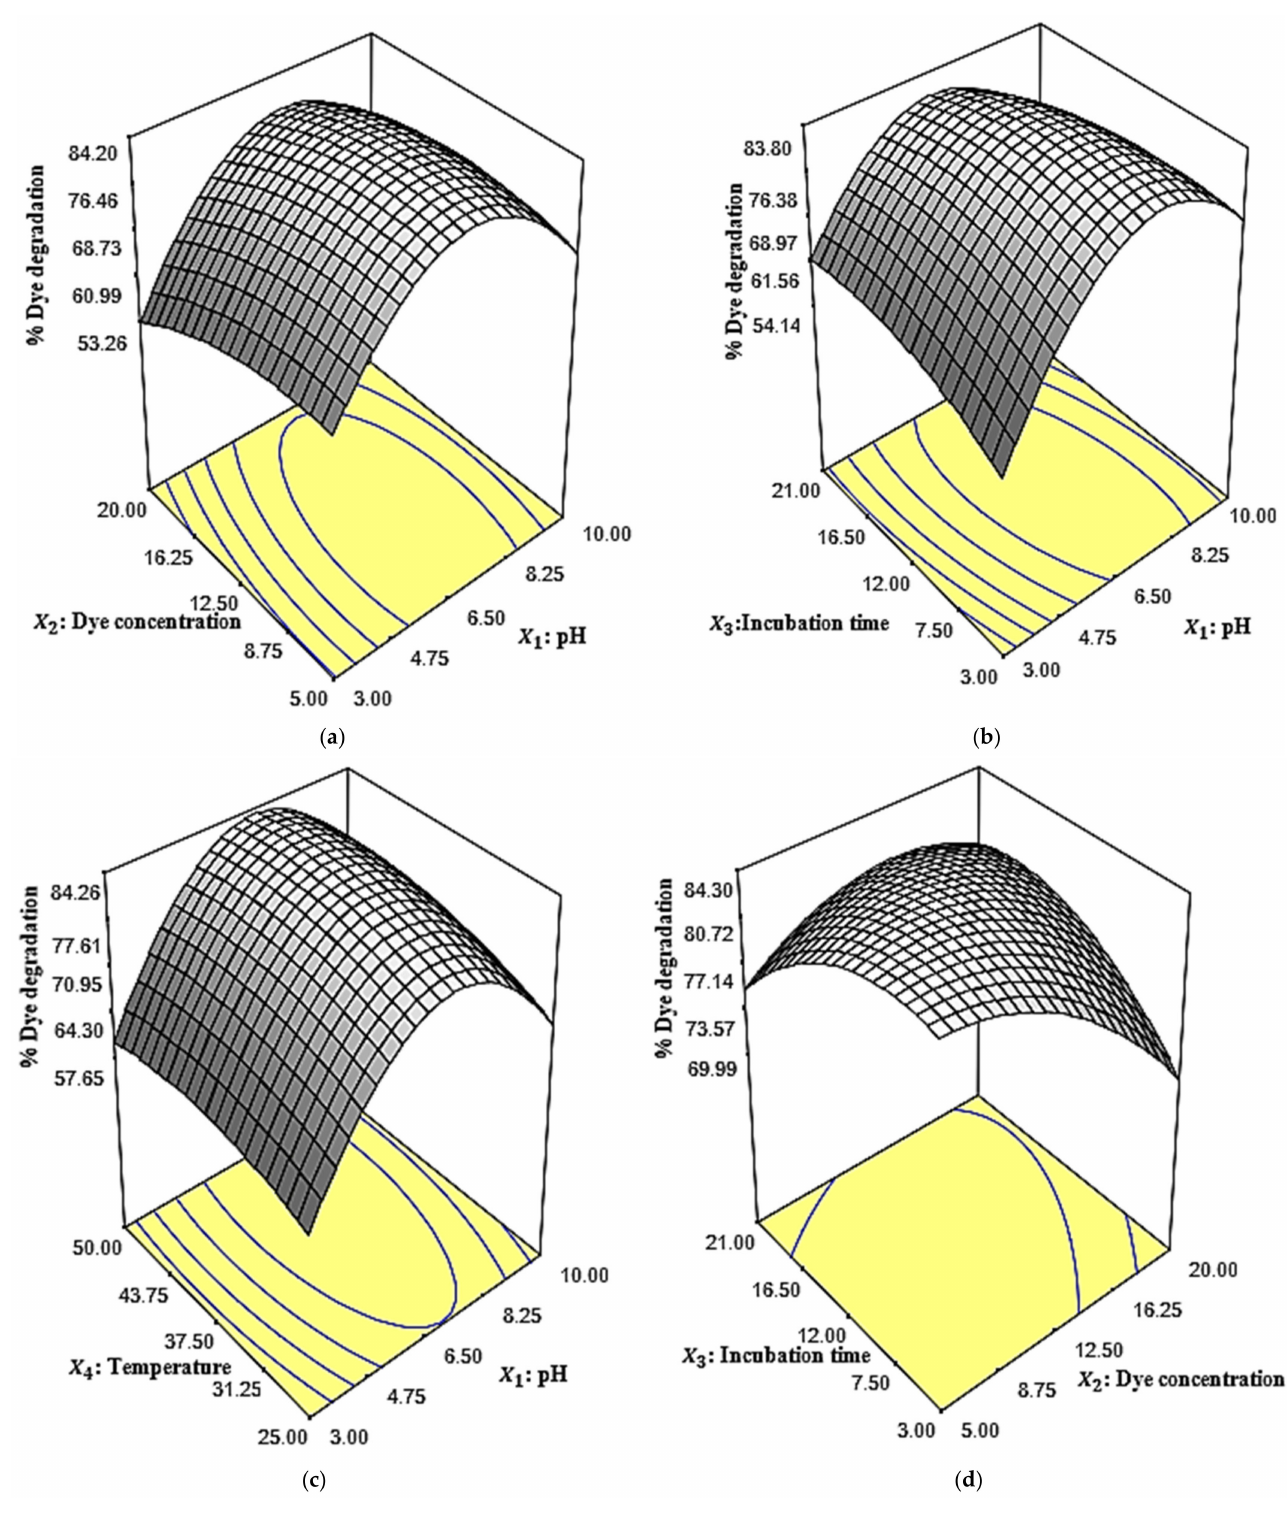
Figure 12. 3D surface plot for the interaction of ( a ) pH and dye concentration, ( b ) pH and incubation time, ( c ) pH and temperature, and ( d ) incubation time and dye concentration, for the degradation of Basic Orange 2 dye using Escherichia coli